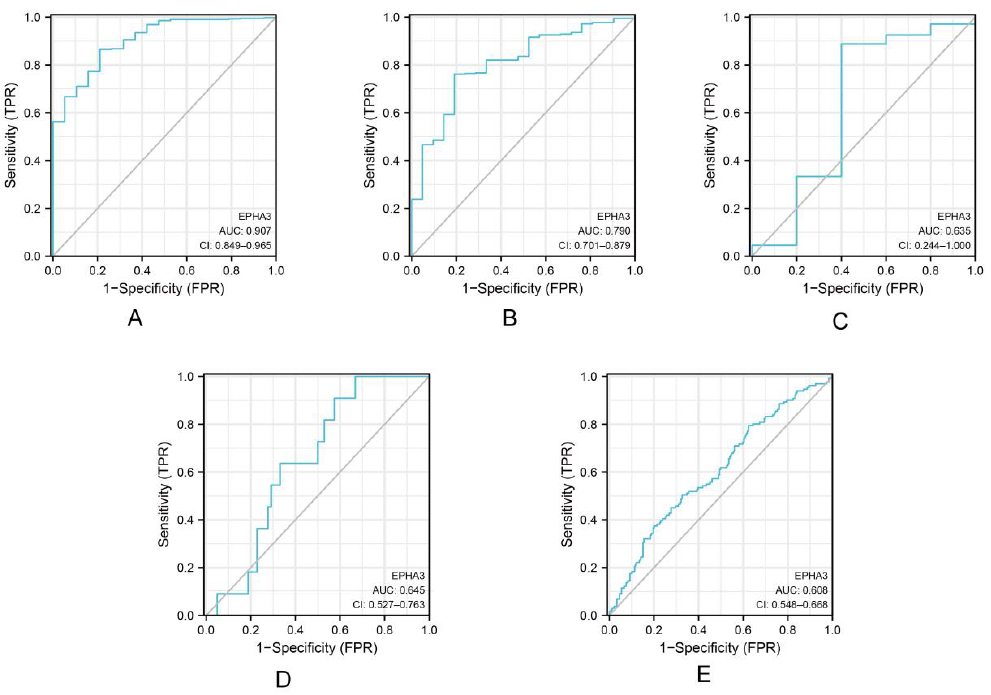
Figure 4. ROC analysis of EPHA3 expression and clinicopathological features from BLCA cases. ROC curves suggest an association between EPHA3 level and status ( A ), histologic grade ( B ), T stages ( C ), M stages ( D ), and N stages ( E ).